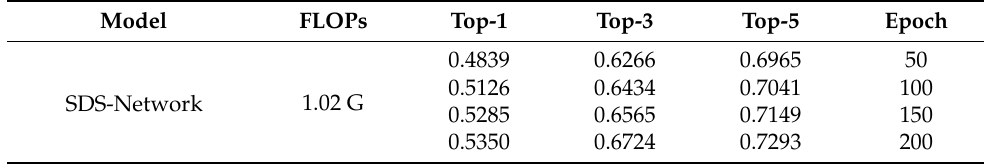
Table 10. SDS-Network data sheet in